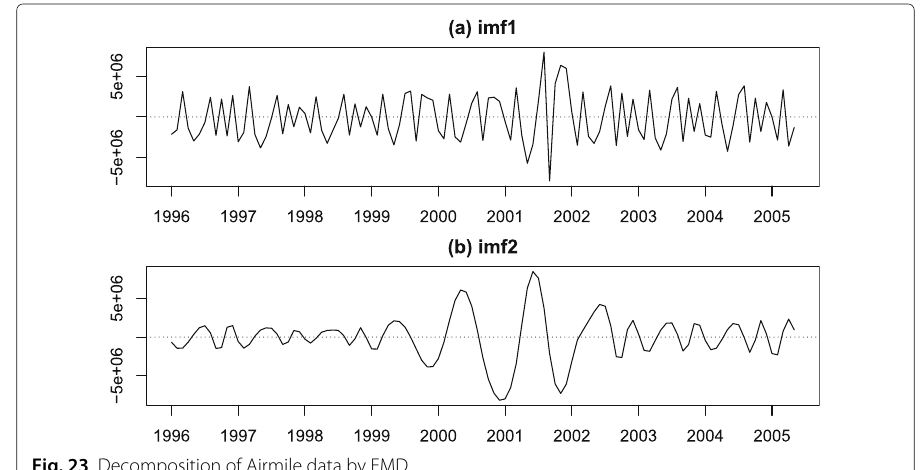
Fig. 23 Decomposition of Airmile data by EMD